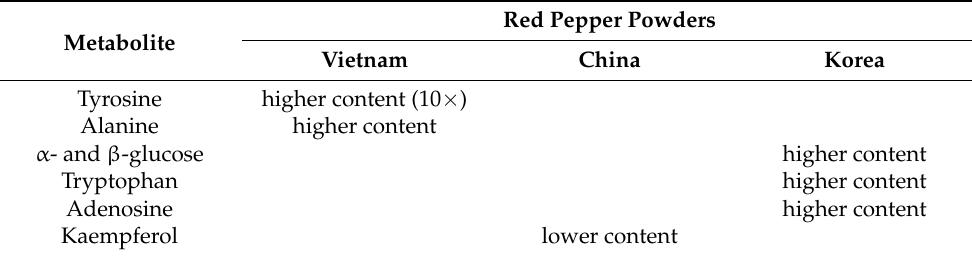
Table 2. Differences in the metabolites contents with respect to geographical origin of red pepper